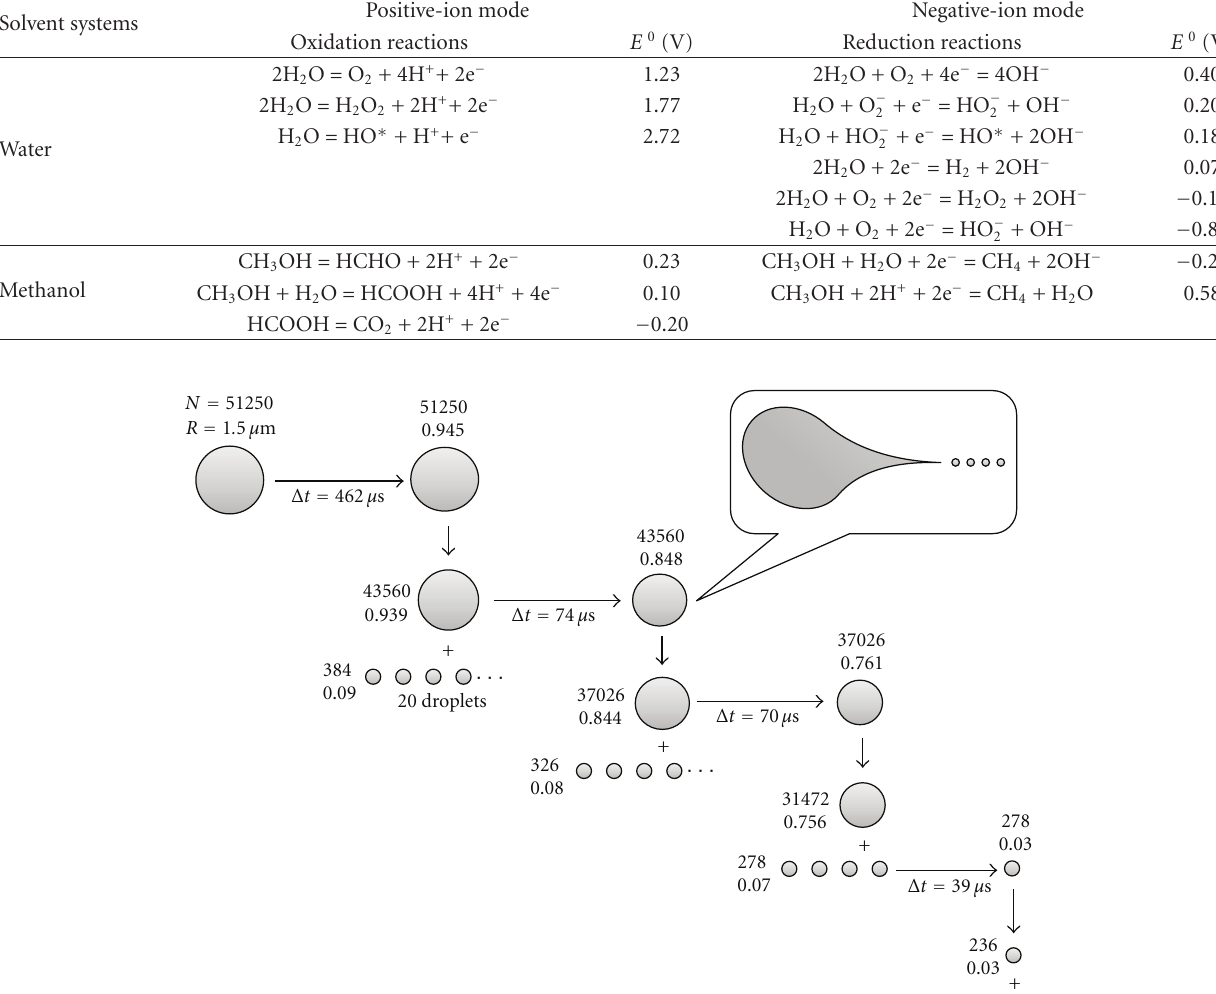
Table 1: Typical redox reactions of the solvents expected to occur in the electrospray emitter and their corresponding standard potentials.